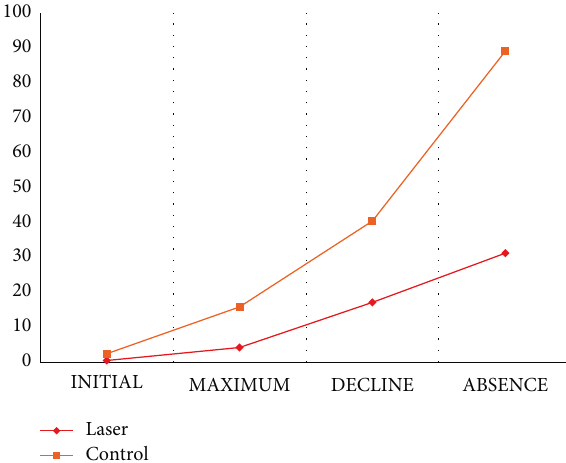
Figure 3: Elapsed time (hours) as a function of pain perception (initial, maximum, decline, and